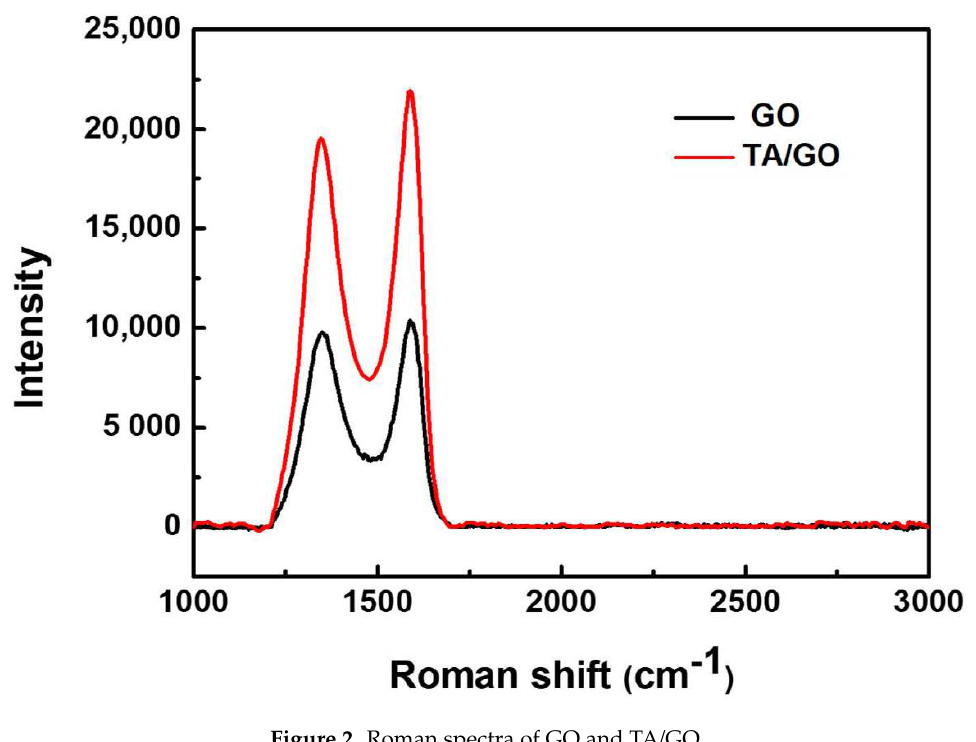
Figure 2. Roman spectra of GO and TA/GO.